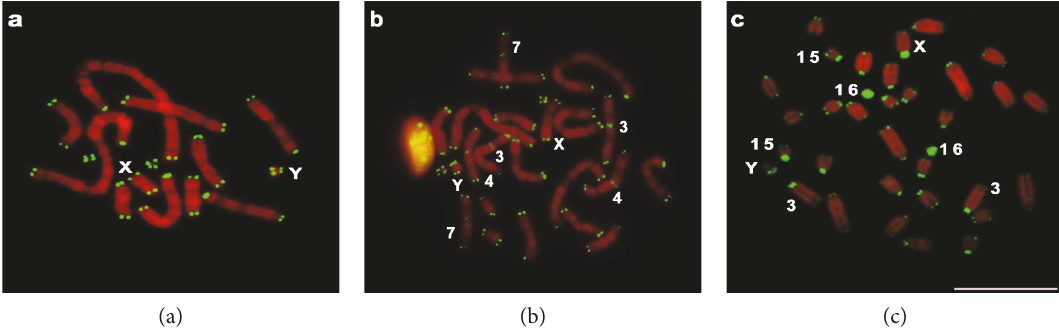
Figure 2: FISH with a telomeric probe in (a) Akodon cursor (2n =14, FN=19); (b) A. montensis (2n =24, FN=42); and (c) Necromys lasiurus (2n =34, FN =34). Bar=10 μ